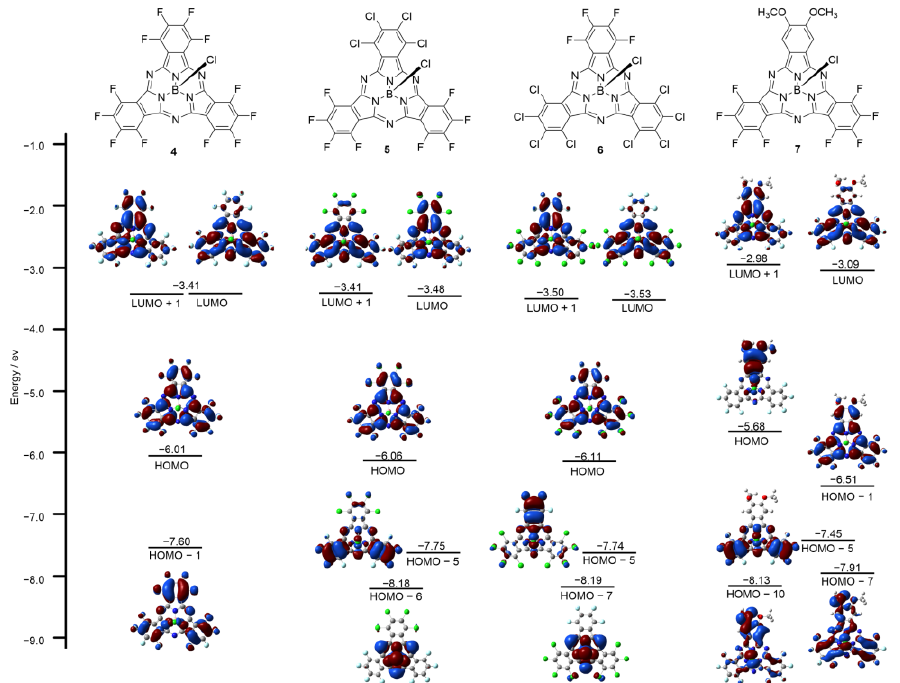
Figure 4. Frontier molecular orbitals and energy diagrams of 4 – 7 , calculated at the B3LYP/6-31G (d,